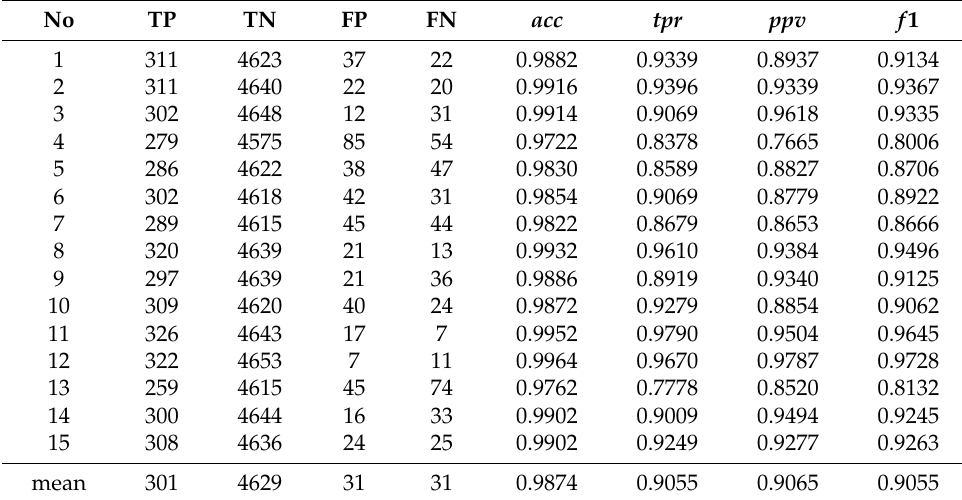
Table 8. Metrics calculated from SNAP_META, 2 × 5000 pixels, 10 trees, OA = 0.9056 (compare mean value acc ).